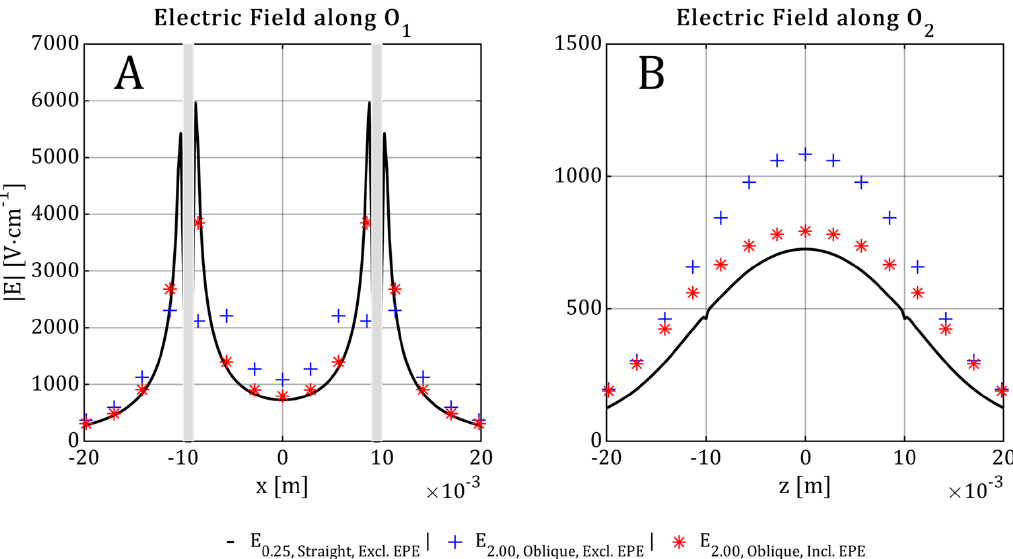
Figure 13. Electric-field distributions of Case 2 within the x,z-plane of the tumor model in Figure 5. Electric-field distribution of the high-resolution model (black line), and low-resolution models excluding EPE (+) and including EPE (*) along the lines O 1 ( A ) and O 2 ( B ). The grey rectangles represent the electrodes.